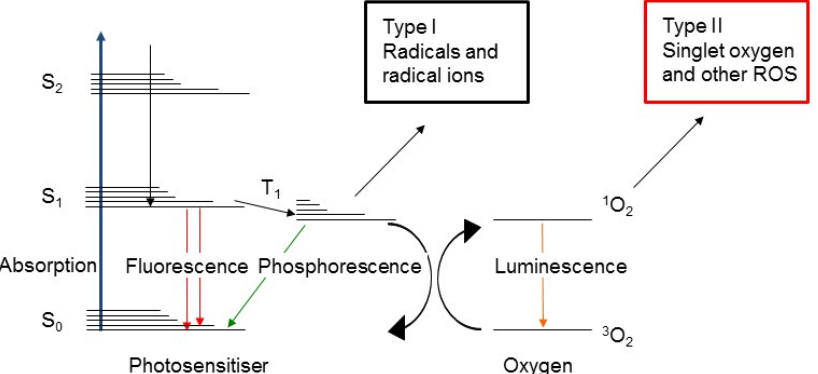
Figure 1. Schematic representation of type I and type II reactions following photosensitizer activation upon illumination.